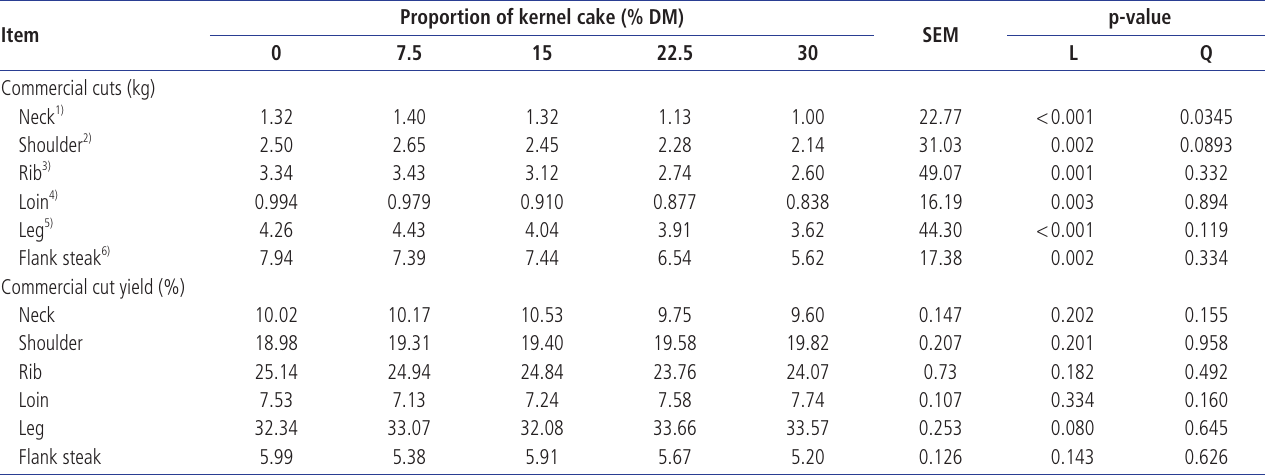
Table 3. Commercial cut weight and yield of lambs fed diet with palm kernel cake